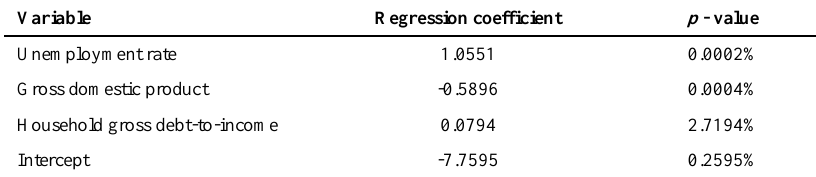
Table 4. Model #46 regression coefficients and p